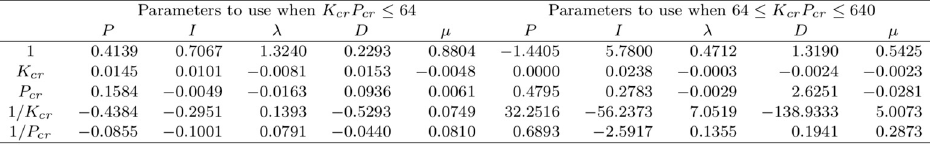
Figure 6. Parameters for the first set of tuning rules for processes with critical gain and period ( P = k p , I = k p /T i , D = k p T d ) [42].